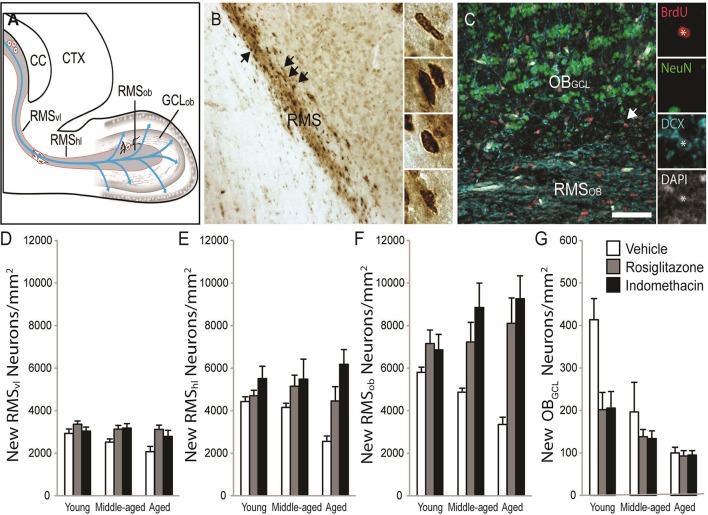
Indomethacin and rosiglitazone increase subependymal neurogenesis region-dependently. (A) A horizontal rat brain schematic showing the RMSVL, RMSHL, RMSOB, and OBGCL where new cell densities and phenotypes were quantified. (B) Transmitted light photomicrograph of new BrdU+ cells revealed by DAB (in brown) migrating along the RMSHL under a 20x objective. Arrows show examples of BrdU+ cells in the insets imaged under a 40x objective. (C) Confocal image of the olfactory bulb taken with a 20x objective (1.5 digital zoom). Most BrdU+ cells (in red) in the RMS expressed DCX (in blue) and a few BrdU+ cells in the OBGCL expressed DCX and NeuN (in green). The inset shows each marker independently in a migrating BrdU+/DCX+ RMSOBneuroblast. The scale bar = 50 μm. (D) Densities of migrating neuroblasts were higher in the RMSVL of young (p < 0.05) and tended to higher in the RMSVL of middle-aged (p = 0.07) vs. aged rats and indomethacin (p < 0.05) and rosiglitazone (p < 0.01) treatment increased densities relative to vehicle. (E) In the RMSHL, densities of migrating neuroblasts were higher in indomethacin- vs. rosiglitazone- (p < 0.05) and vehicle- (p < 0.001) treated rats and in rosiglitazone- vs. vehicle- (p < 0.05) treated rats. (F) In the RMSOB, indomethacin (p < 0.001) and rosiglitazone (p < 0.001) increased neuroblasts/neuron densities relative to vehicle primarily because indomethacin increased densities in middle-aged rats (p <0.05 vs. vehicle) and indomethacin and rosiglitazone increased densities in aged rats (p <0.05 and p < 0.001 vs. vehicle, respectively). (G) Generally, young rats had higher OBGCL neuron densities than middle-aged (p < 0.001) and aged (p < 0.001) rats and middle-aged rats tended to have higher densities than aged rats (p = 0.07). Indomethacin and rosiglitazone reduced densities relative to vehicle (p < 0.01), primarily because lower densities were observed in indomethacin- (p < 0.001) and rosiglitazone- (p < 0.05) vs. vehicle-treated young rats.